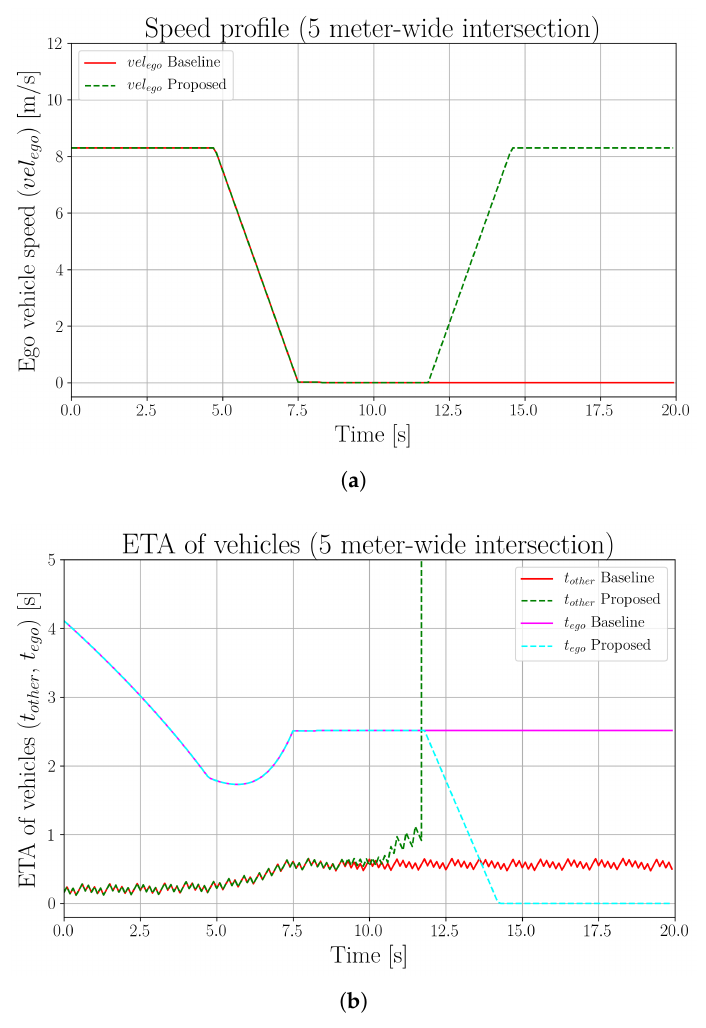
Figure 14. Comparison of the proposed and baseline planners at a 5 m wide occluded intersection. ( a ) Ego vehicle speed profiles at a 5 m wide occluded intersection. ( b ) Estimated times of arrival of vehicles at a 5 m wide occluded